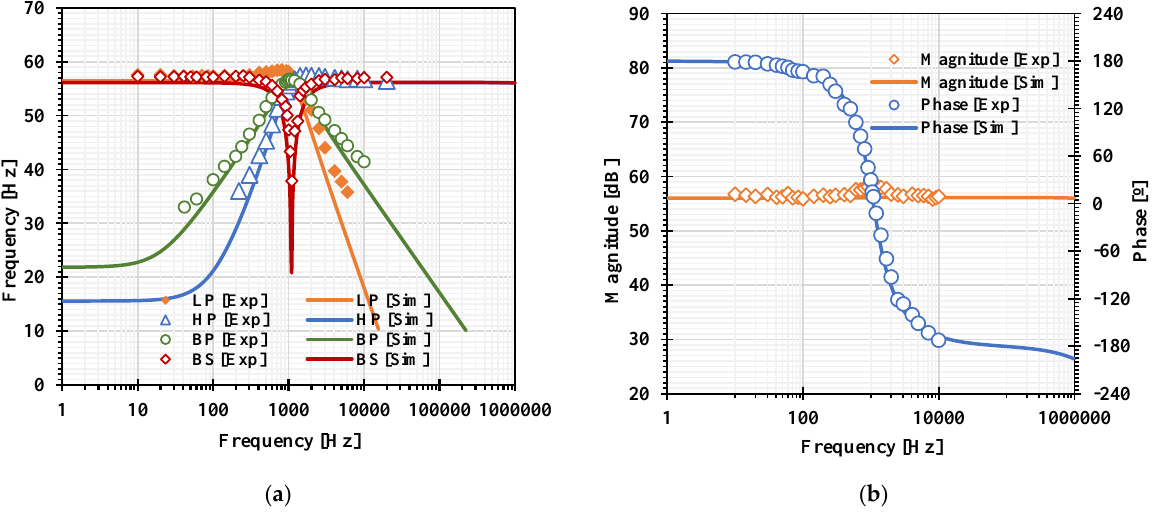
Figure 20. Experimental frequency responses of the TIM filter: ( a ) LP, BP, HP, BS filters; ( b ) AP filter.